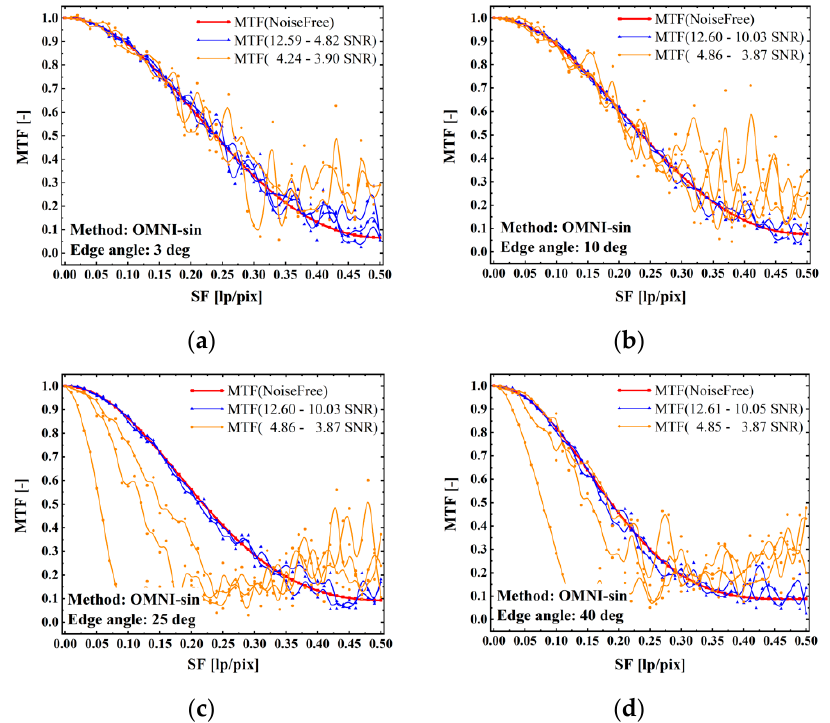
Figure 15. MTF for some tilt angle BNDE images with different SNR ( ∞ , 12.6, 10.0, 4.8, 4.2, 3.9) using OMNI-sin edge method: ( a ) when edge angle is 3 deg, ( b ) when edge angle is 10 deg, ( c ) when edge angle is 25 deg, ( d ) when edge angle is 40 deg.